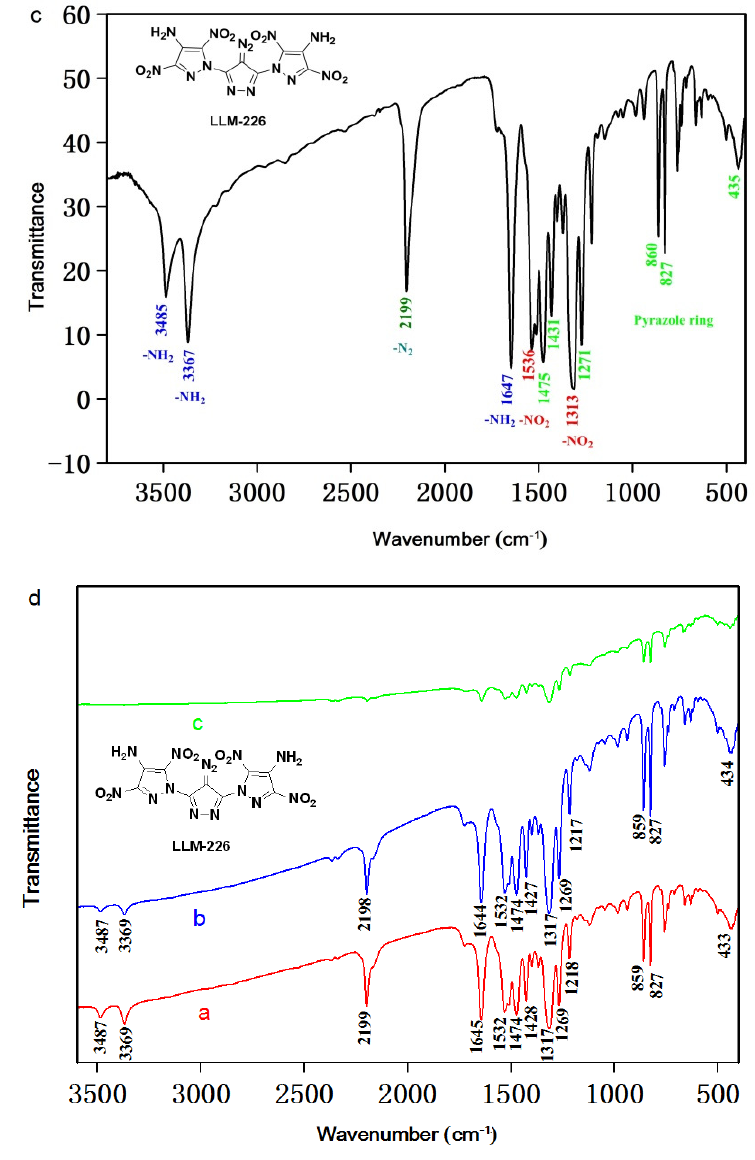
Figure 4. In-situ FTIR spectroscopy of LLM-116 ( a , b ) and LLM-226 ( c , d ) at different temperatures. To further clarify the corresponding decomposition processes of the similar energetic heterocycles, systematic simulation studies were then carried out. ReaxFF is a method for modeling chemical reactions with atomistic potential based on the reactive force field approach [25], and calculations based on ReaxFF force field were performed with details of the initial reactions discussed to get a deep understanding of the decomposition processes of LLM-116 and LLM-226. The energy of the system was calculated based on Equation (1), in which the E bond , E over , E under , E val , E tor , E lp , E Coul , and E vdw refer to corresponding bond energy, over-coordination penalty energy, under-coordination correction energy, valence angle energy, torsion angle energy, lone-pair electron energy, Coulomb interaction energies, and van der Waals interaction energy,